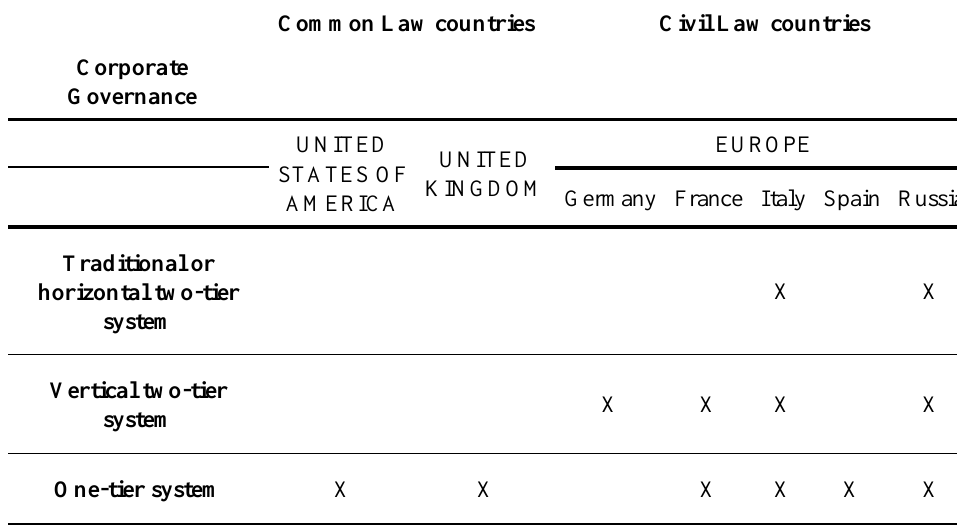
Table 2 : National Legal Systems and Governance